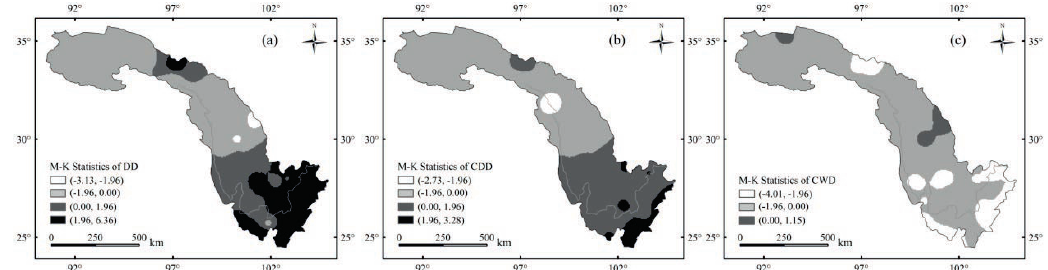
Fig. 8 Spatial changes of M-K statistics of other indices during 1961–2010: (a) DD, (b) CDD, and (c)